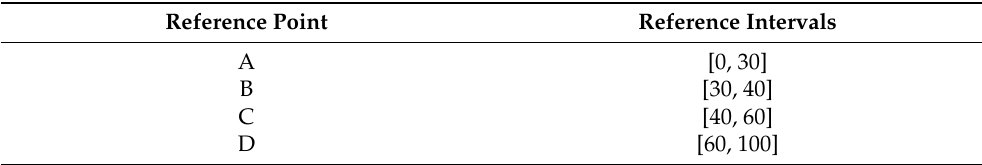
Table 7. Reference point and reference intervals of premise attribute 1.